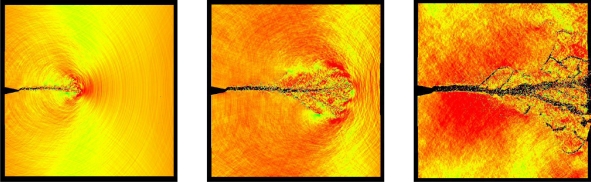
Snapshots of a 2D FEM simulation of the fracture process of a PMMA (poly-methyl methacrylate) plate which is subject to an initial uniform strain rate in vertical direction. Here, there is no statistical variability of the microstructure modeled with more than 50 × 106 elements. Thus, the model solid has to be artificially pre-notched and it still exhibits a strong dependence on the mesh size and the number of elements. Adapted from [202].